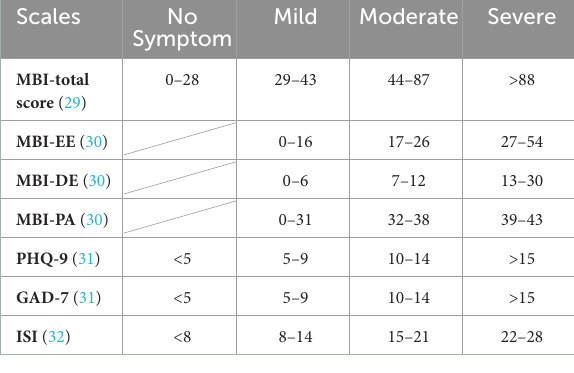
TABLE 1 The severity levels of the scales.